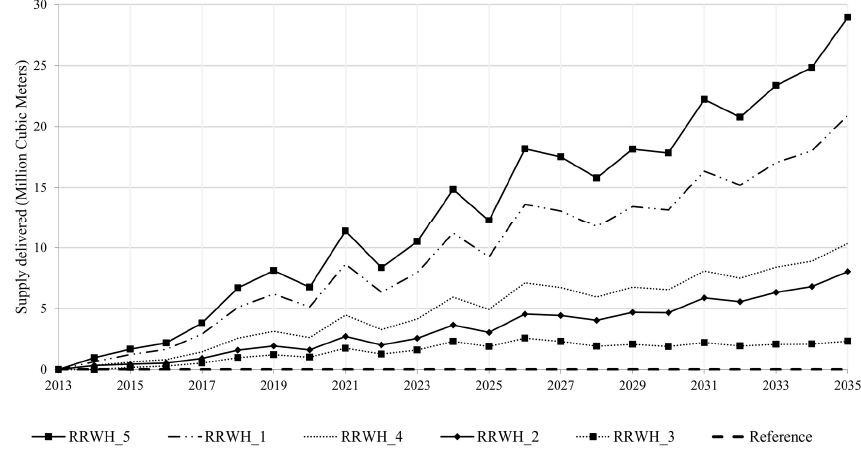
Figure 8. Additional water supply delivered under different RRWH scenarios for Mombasa City.